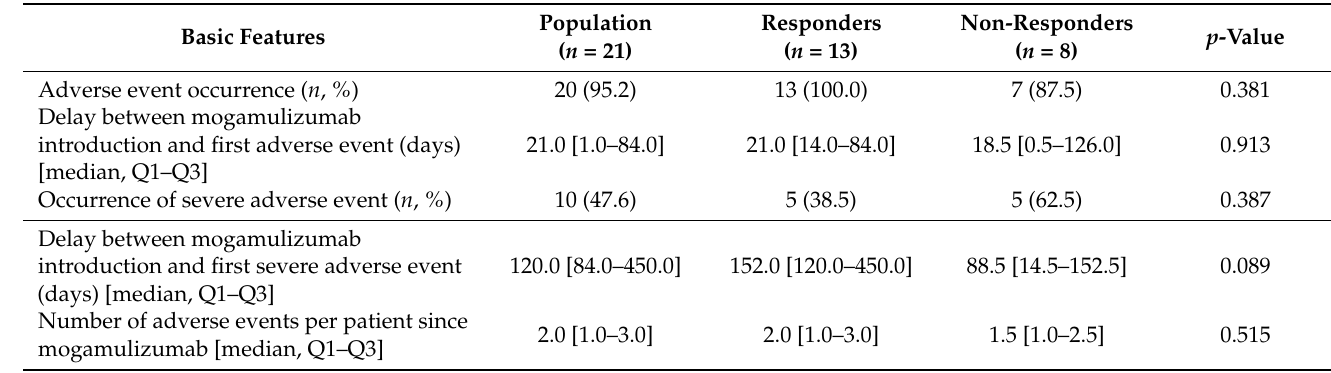
Table 3. Descriptive table of adverse events during mogamulizumab treatment. p -value obtained using Fisher exact test for qualitative variables and using Mann–Whitney U test for quantitative